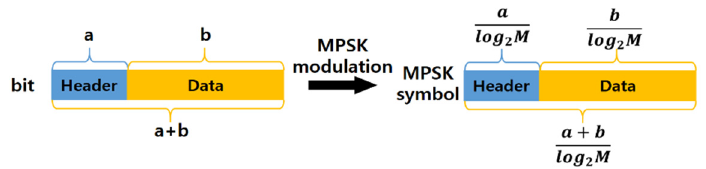
Figure 7. Transformation process of conventional bits to symbols.